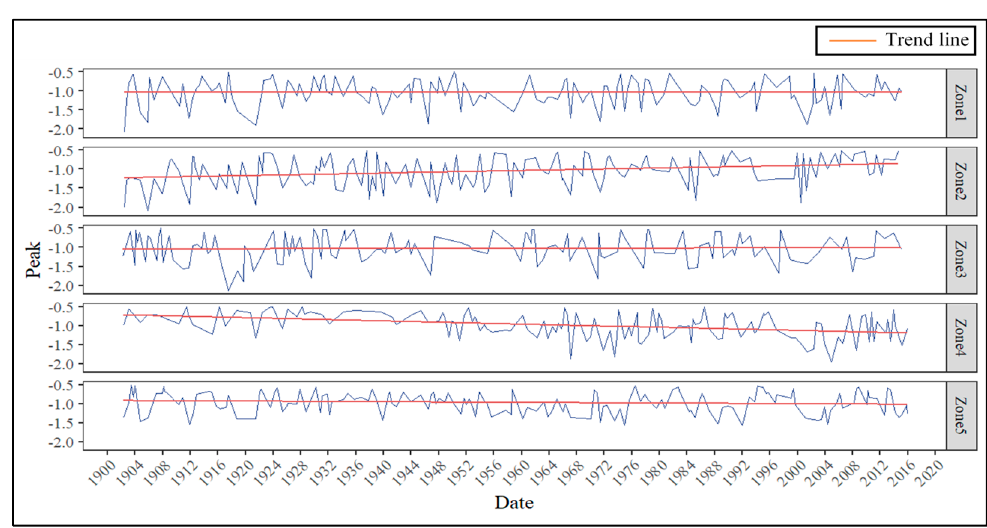
Appl. Sci. 2019 , 9 , x FOR PEER REVIEW Figure 17. Drought intensities for each zone. Figure 17. Drought intensities for each zone.